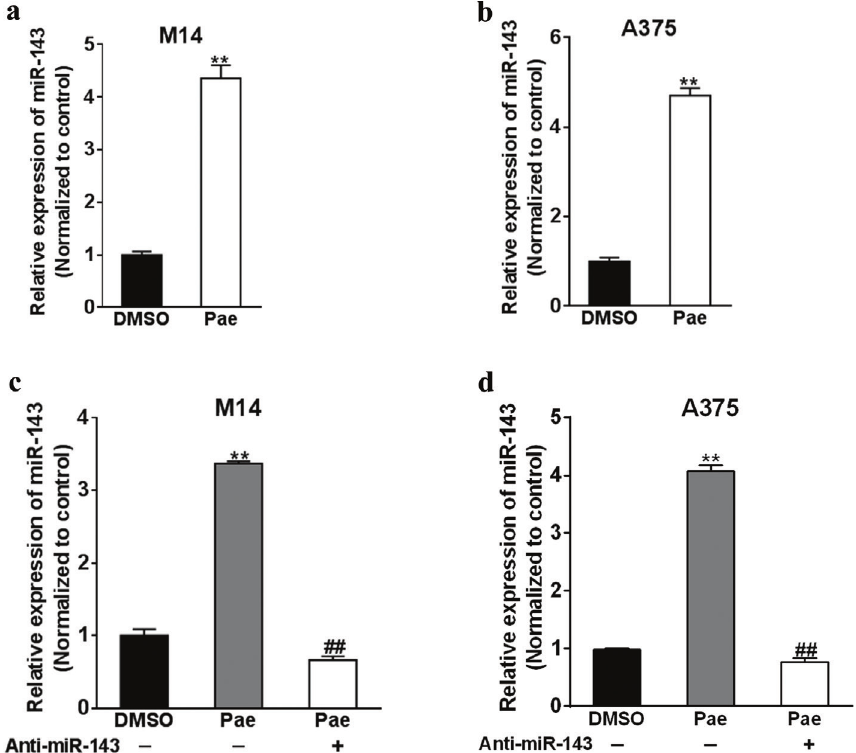
Fig. 2 . Paeonol (Pae) induces the expression levels of miR-143. (a, b) M14 and A375 melanoma cells were treated with 500 μM Pae or DMSO, after 24 h the relative expression levels of miR-143 were analyzed by qRT-PCR. ** P < 0.01 versus control. (c, d) M14 and A375 melanoma cells were transfected with Anti-miR-143 or Anti-miR-NC, and were treated with 500 μM Pae or DMSO. After 24 h the relative expression levels of miR-143 were analyzed by qRT-PCR. ** P < 0.01 versus DMSO+An- ti-miR-NC group. ## P < 0.01 versus